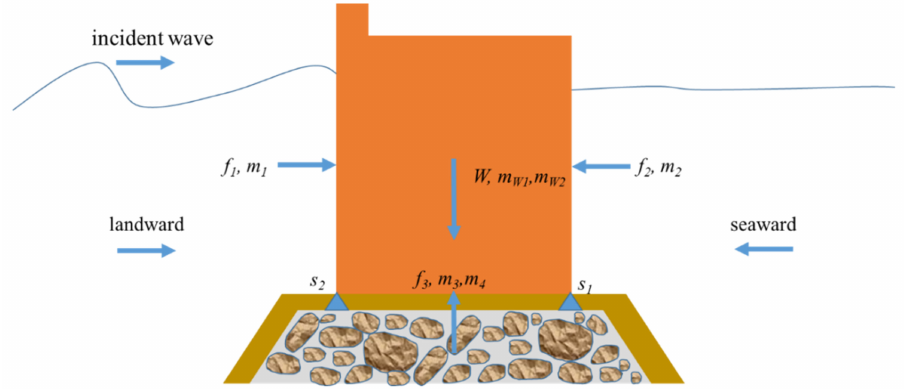
Figure 6. Free body diagram of load